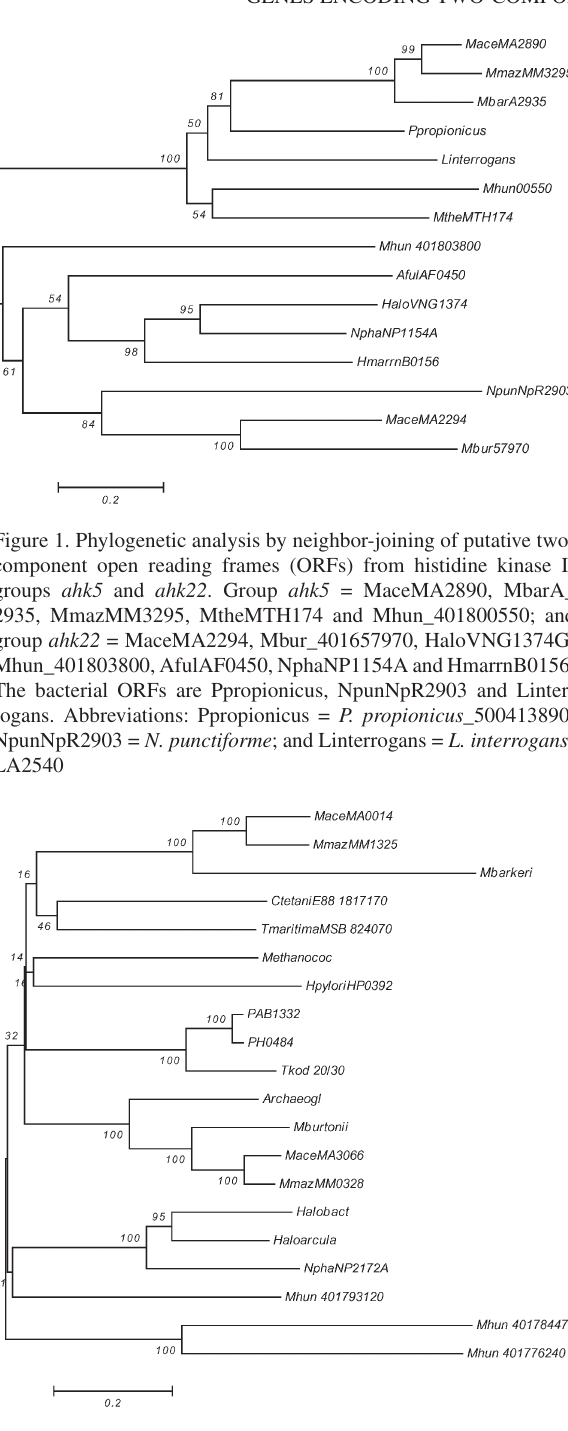
Figure 2. Phylogenetic analysis by neighbor-joining of putative two- component open reading frames (ORFs) from the histidine kinase IV groups ahk40–43 . Group ahk40 = MaceMA3066, MmazMM0328, AfulAF1040 and Mbur_401647520; group ahk41 = MaceMA0014,